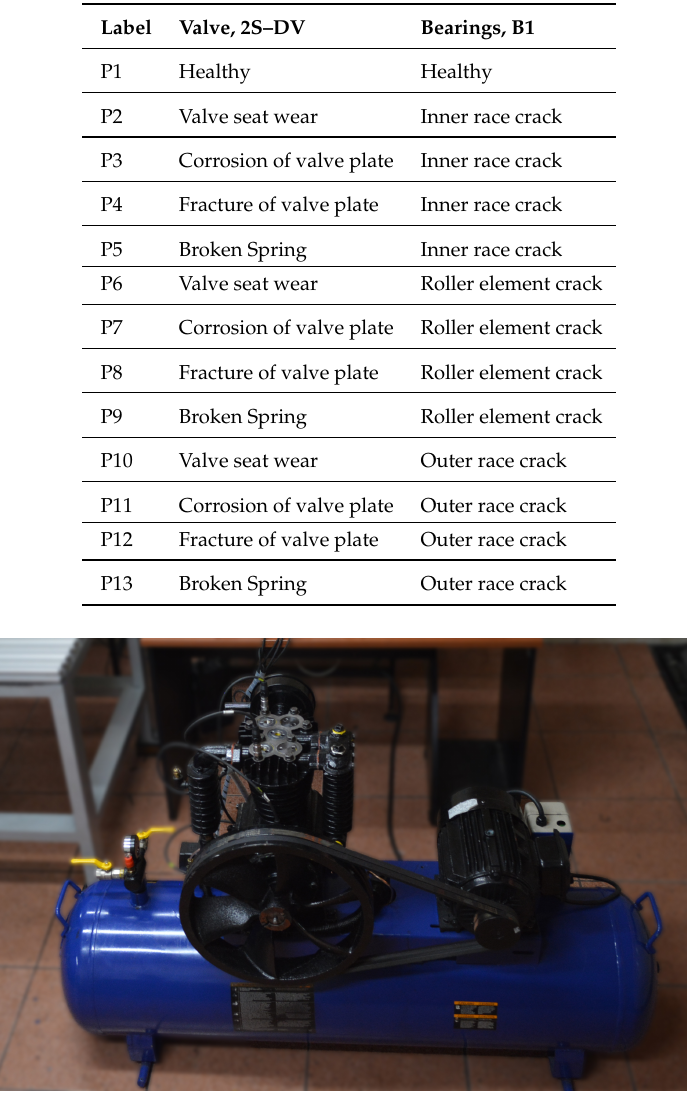
Figure 8. Compressor model EGB-250 available at the Universidad Politécnica Salesiana.